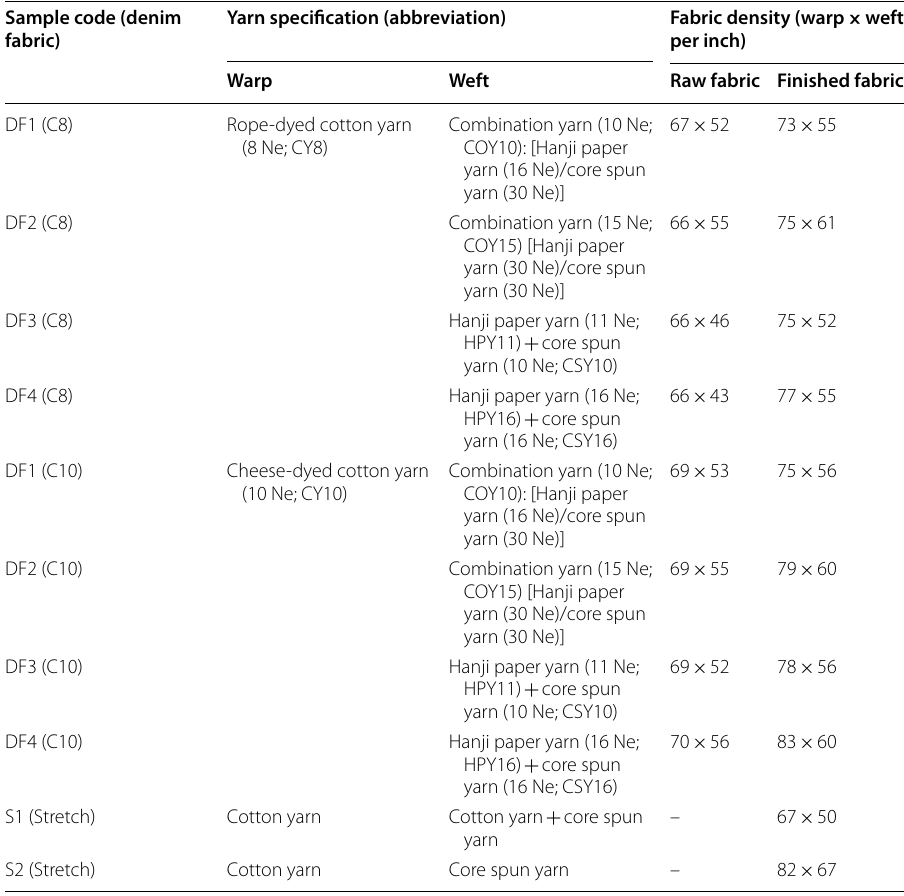
Table 1 Specifications of Hanji denim fabrics Sample code (denim